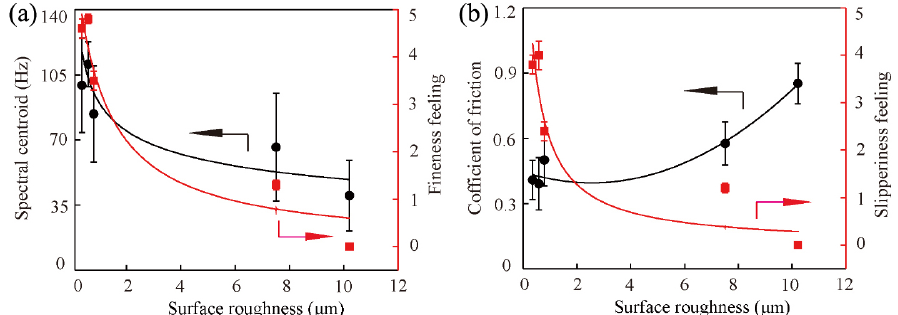
Fig. 7 Relationship between (a) SC and fineness feeling and (b) coefficient of friction and slipperiness feeling when a finger touches different surface roughness